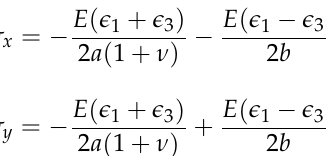
Figure 8. Mesh sensitivity study.